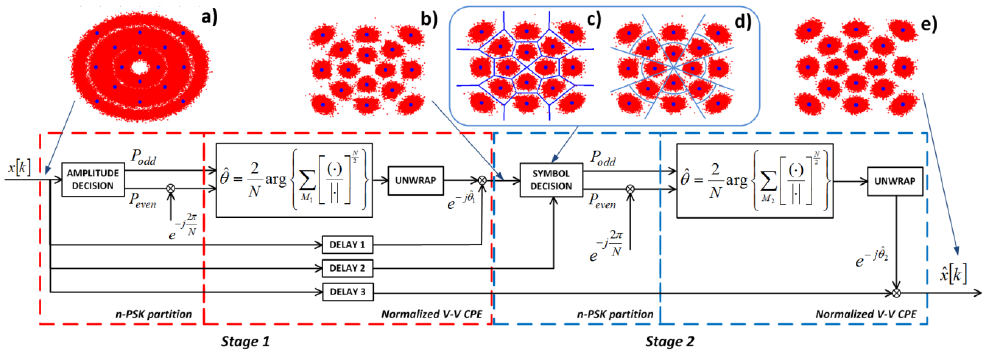
Figure 2. Block diagram of the proposed two-stage n-PSK partitioning carrier phase recovery (CPR) scheme. ( a ) Input symbols. ( b ) Estimated constellation after first stage. ( c ) Detection of symbols with optimal decision boundaries. ( d ) Detection of symbols using sub-optimal decision boundaries (an